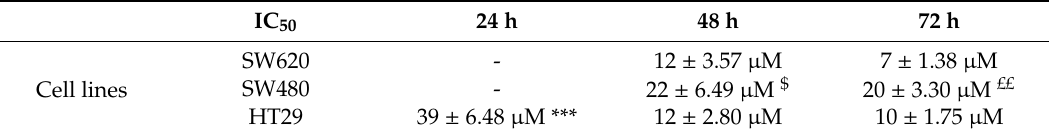
Table 1. Inhibitory concentration 50% (IC 50 ) values determined from cell viability assays for xanthohumol on the colon cancer cell lines at the di ff erent times of